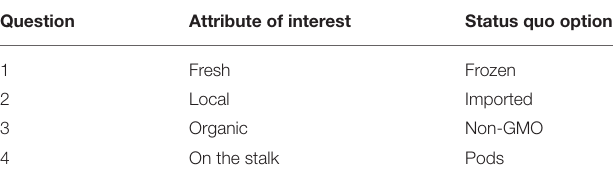
TABLE 1 | Alternatives in each of the OOHB-DC CV questions.